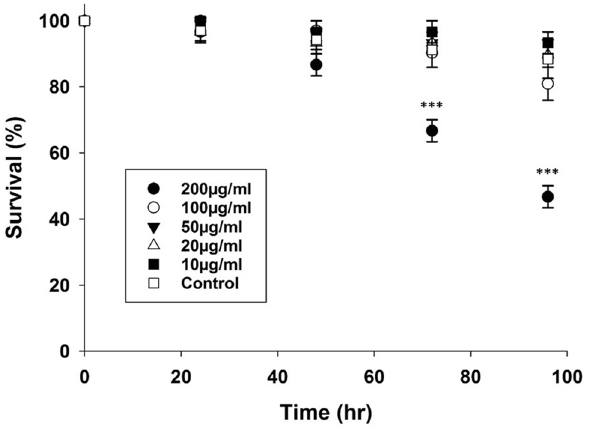
Figure 1. Survival of 4th instar T. castaneum larvae following injection with different dosages of PAMAM- CNTs (10–200 µg/mL) or control solution. Mortality was monitored every 24 h following microinjection. At 72 and 96 h post-injection, there was significantly increased mortality in groups injected with 200 µg/mL PAMAM- CNTs relative to controls (72 h, P = 0.029; 96 h, P = 0.008). No other dosages significantly impacted the survival of T. castaneum over the observed period. Data are means ± SEM. Three replicate groups per treatment (n = 9–13 larvae